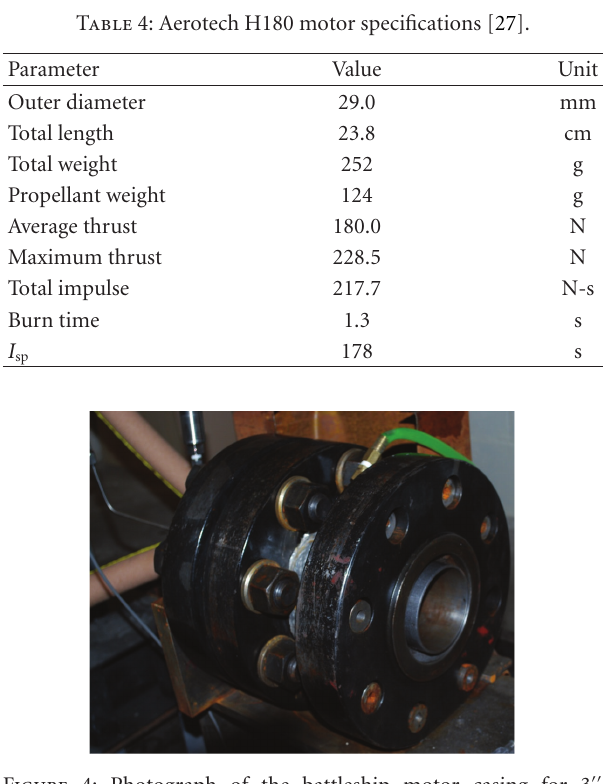
Figure 4: Photograph of the battleship motor casing for 3 (cid:4)(cid:4) diameter propellant grains.